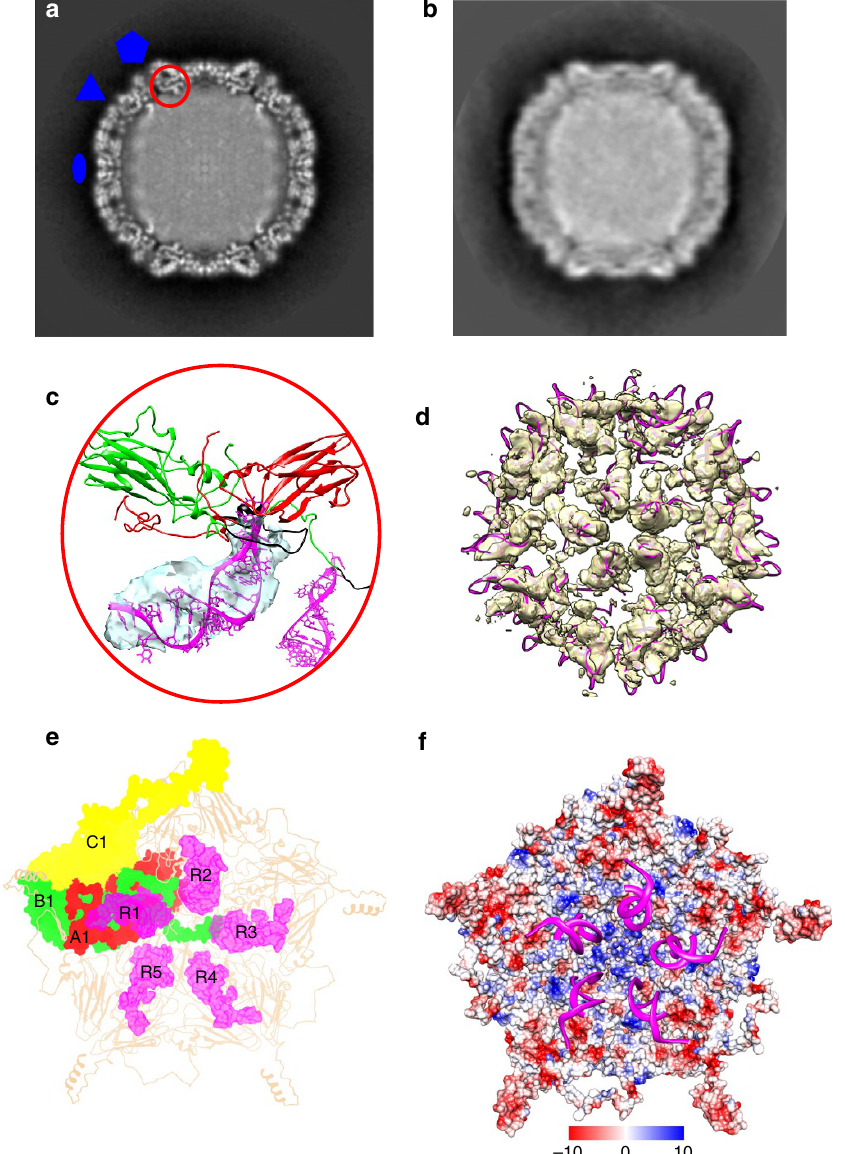
Figure 2 | Ordered RNA–protein interactions. ( a ) Central cross-section of the unfiltered HPeV3 icosahedrally-symmetric reconstruction with three symmetry axes marked. The red circle in ( a ) and ( c ) indicates one of the regions where the capsid proteins interact with finger-like RNA densities. ( b ) Central cross-section of the unfiltered HPeV3 asymmetric reconstruction. ( c ) Enlargement of the VP3 (green) and VP1 (red) atomic model in intimate contact with an RNA model (magenta, R1) within its asymmetric unit. The VP3N terminus also interacts with a neighbouring RNA molecule within the pentamer. The fit of one of the RNA models in the RNA EM density (transparent isosurface) is shown. The RNA interacting regions in VP1 and VP3 are coloured black. ( d ) The icosahedrally-symmetric copies of the fitted-RNA model from c shown in the HPeV3 asymmetric reconstruction’s RNA density (yellow transparent surface shown at 2 s above the mean threshold). ( e ) VP1 and VP3 interaction with the RNA is shown in the context of the inner surface of a pentamer. The N terminus of VP3 (B1) and regions of VP1 (A1) interact with the RNA (R1) within its asymmetric unit and also with an RNA (R3) from the next-but-one asymmetric unit within a pentamer. The proteins are marked as in Fig. 1c. The RNA models are marked R1-R5 for their respective asymmetric units as in Fig. 1c). ( f ) The inner surface of a pentamer of the HPeV3 model shown as an electrostatic potential surface with the conserved RNA motif (magenta) shown in ribbon. The scale for the charge distribution is also shown. The RNA interaction with the capsid protein does not appear to be driven by electrostatics as the interacting region on the capsid proteins appear to be a mix of positive (blue), negative (red) and neutral charges pocket-factor mimics will not work against any of the HPeV so far sequenced.